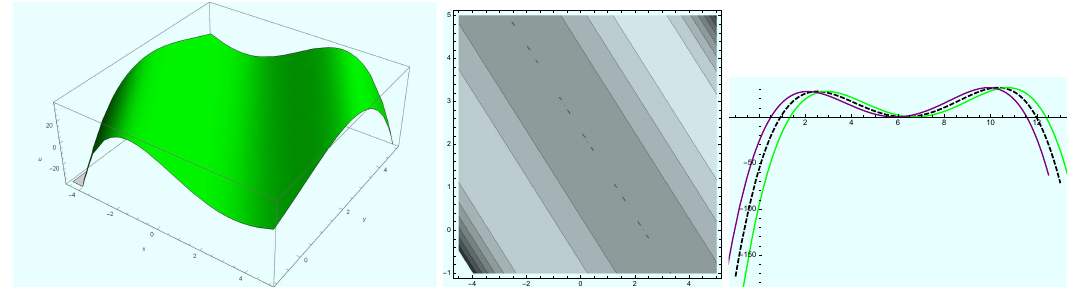
Figure 16. Evolution of traveling wave of series solution (34) at t = 1.6 and z = 1.1.